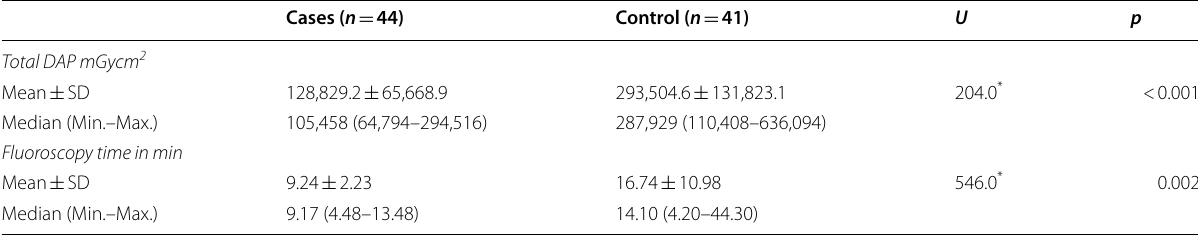
U: Mann–Whitney test, p: p value for comparing between the two studied groups * : Statistically significant at p ≤